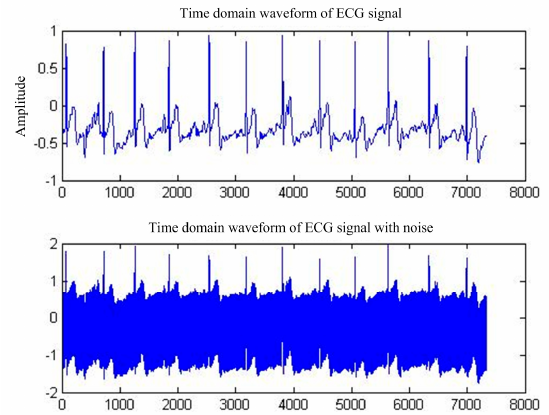
Figure 9. Before and after the impact of PLI by the ECG waveform.